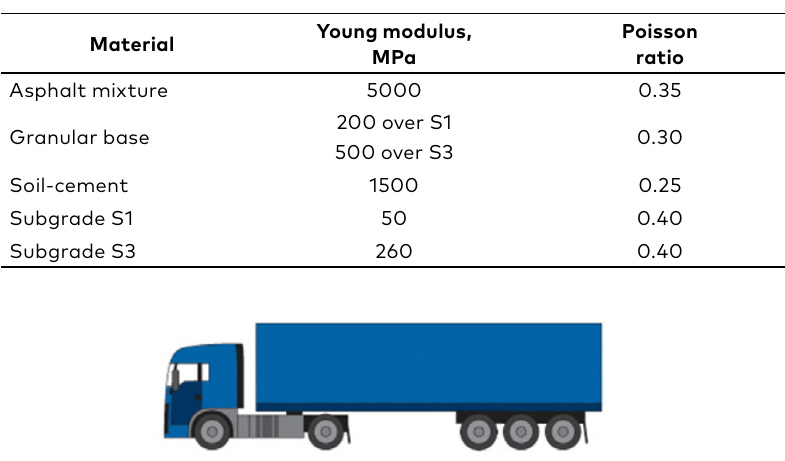
Table 4. Young modulus and Poisson ratio of the layers considered in the analysis